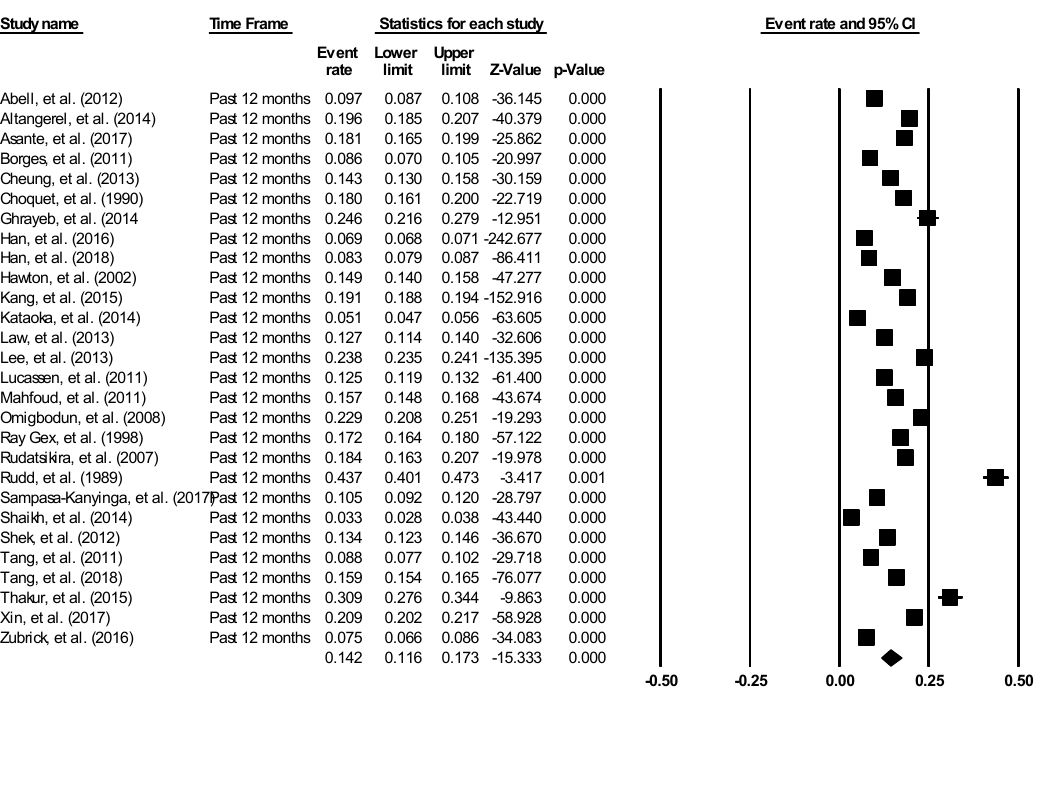
Figure 6. Forest plot of the aggregate 12-month prevalence of suicidal ideation.